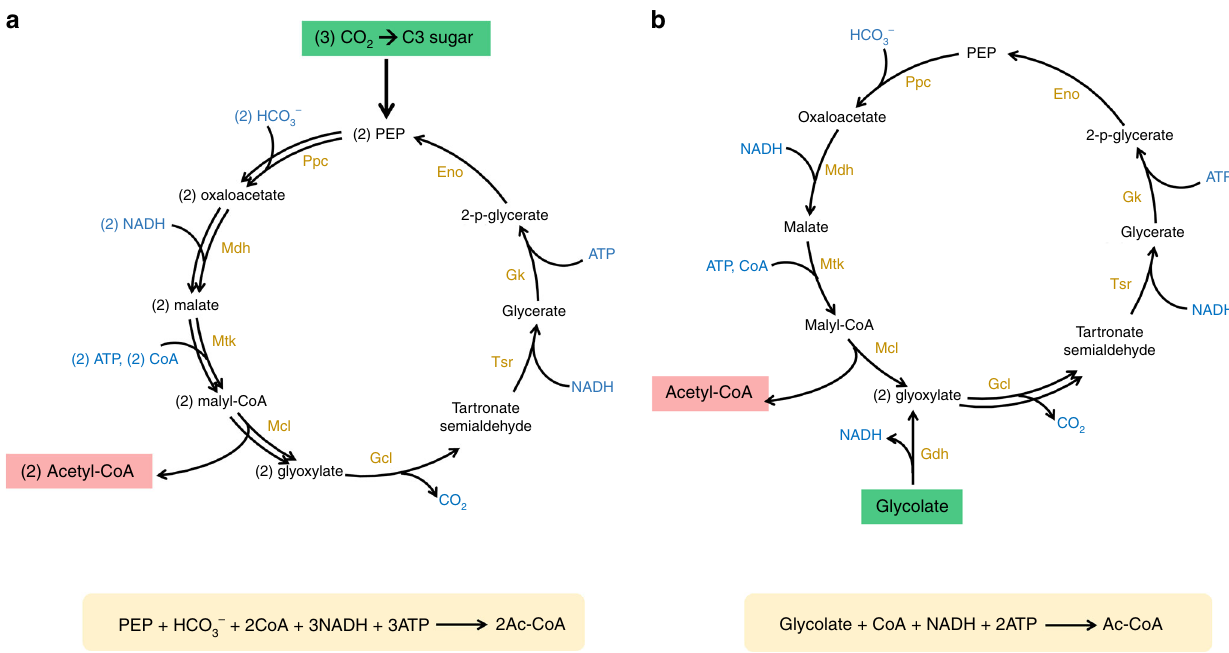
Fig. 1 Design of the MCG pathway for ef fi cient acetyl-CoA synthesis. a The MCG pathway can convert one C3 sugar to two acetyl-CoA via fi xation of one CO 2 equivalent. PEP, phosphoenolpyruvate; Ac-CoA, acetyl-CoA; Ppc, phosphoenolpyruvate carboxylase; Mdh, malate dehydrogenase; Mtk, malate thiokinase; Mcl, malyl-CoA lyase; Gcl, glyoxylate carboligase; Tsr, tartronate semialdehyde reductase; Gk, glycerate kinase; Eno, enolase. b The MCG pathway, coupling with glycolate dehydrogenase, can assimilate glycolate to acetyl-CoA without net carbon loss. Gdh, glycolate dehydrogenase. The net reactions are shown in the yellow